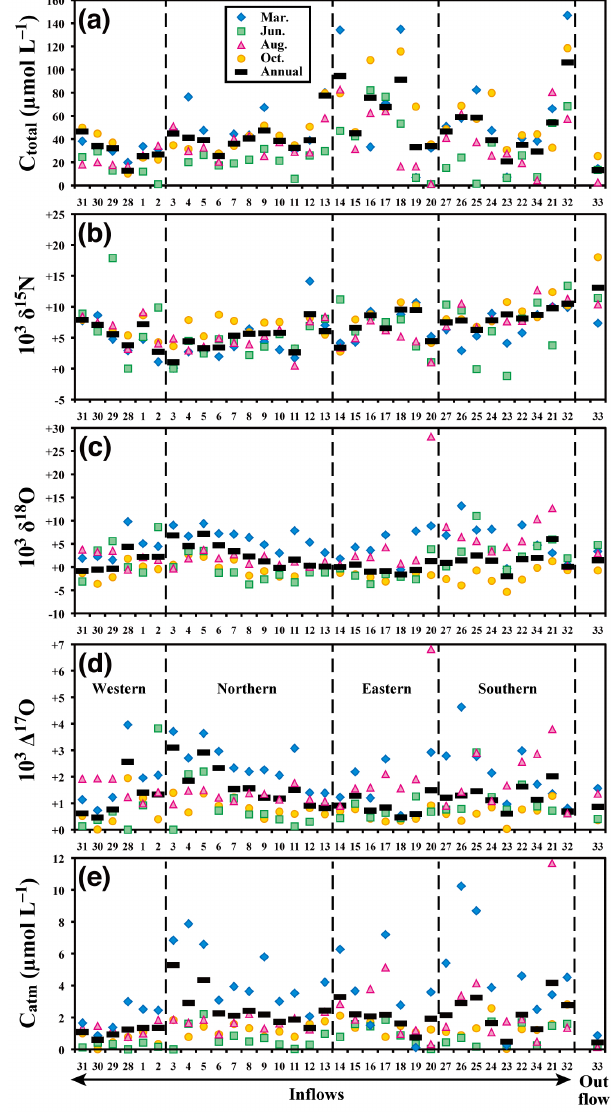
Figure 5. Distribution of (a) total concentrations, (b) δ 15 N, (c) δ 18 O, and (d) (cid:49) 17 O for nitrate and (e) atmospheric nitrate con- centrations in inflow streams by the various station numbers and the outflow station no. 33 in the Lake Biwa watershed in March (blue diamonds), June (green squares), August (red triangles), and Oc- tober (orange circles) 2013 together with the annual averages for each river (black bars). The errors were smaller than the sizes of the symbols except for (e) .